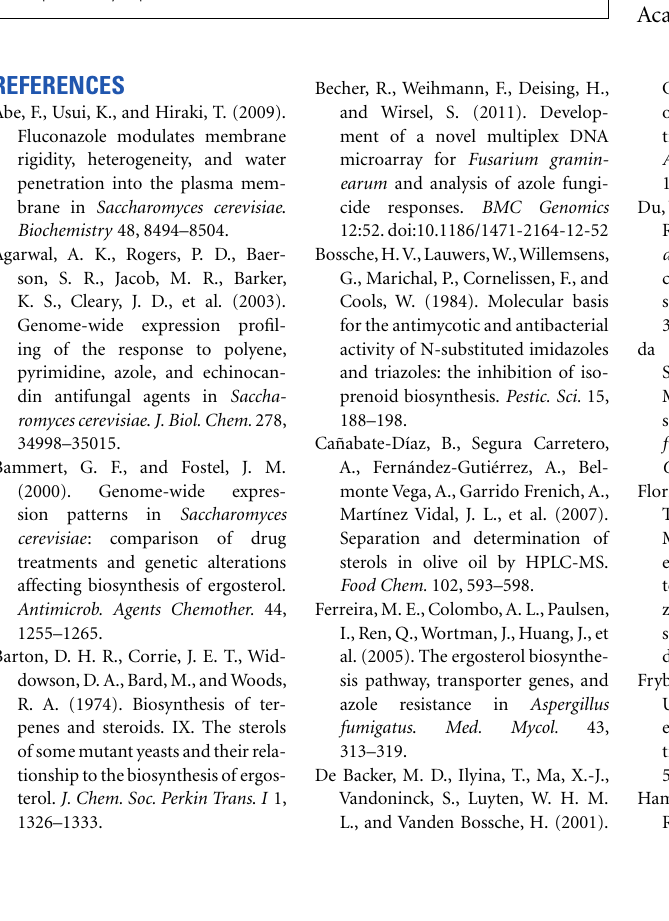
FIGURE 4 | Drug susceptibility analysis of the erg5A (FVEG_07284) and erg5B (FVEG_08786) knockout mutants of F. verticillioides . Two microliters of conidial suspensions with different concentration (1 × 105, 1 × 104, 1 × 103, or 1 × 102conidia/ml, respectively) were inoculated on the plates ( Φ = 9cm) with or without antifungal drugs, and incubated at 28˚C for 72h. Each test had three replicates and the experiment was independently repeated